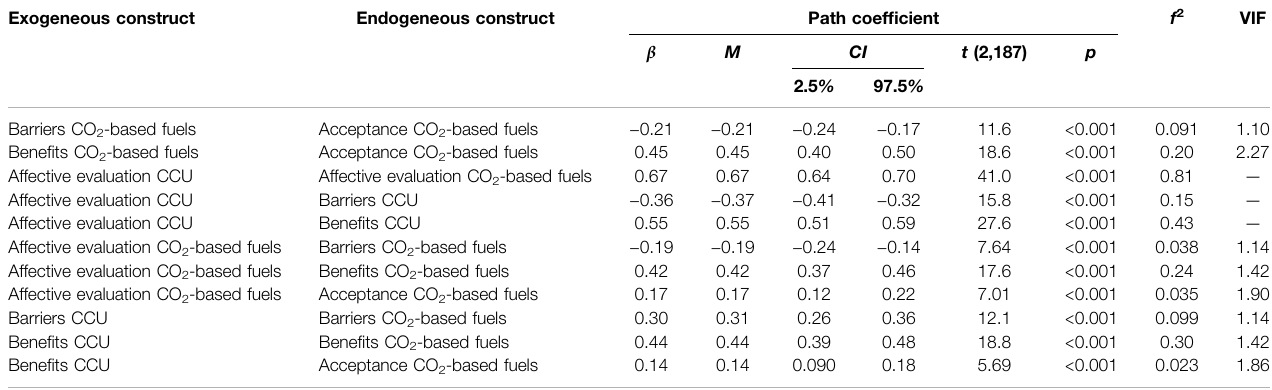
TABLE 6 | Evaluation of the structural model: path coef fi cient evaluation [original estimate β , bootstrapped mean M , con fi dence interval ( CI ), t-test statistic t (2,187), and signi fi cance ( p )], effect size ( f 2 ), and collinearity (VIF).